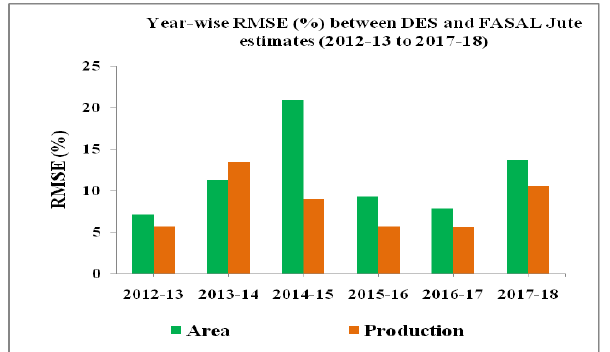
Figure12. DES and FASAL estimates comparison (RMSE %) over the years